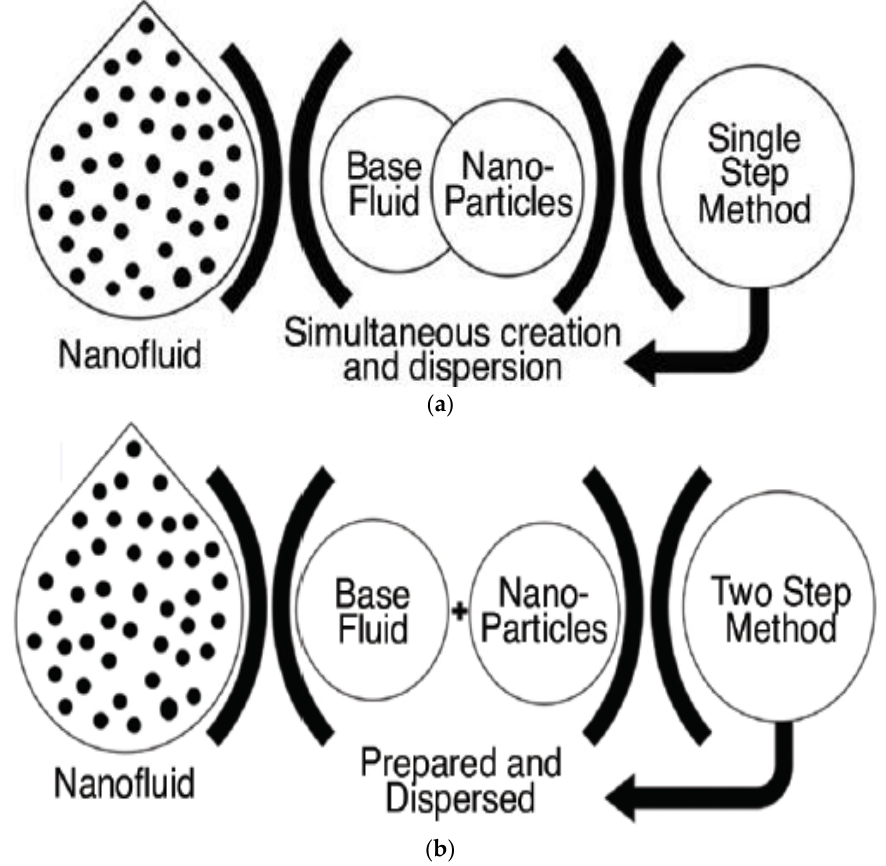
Figure 3. Nanofluid preparation methods ( a ) single-step method ( b ) two-step method. “Reprinted